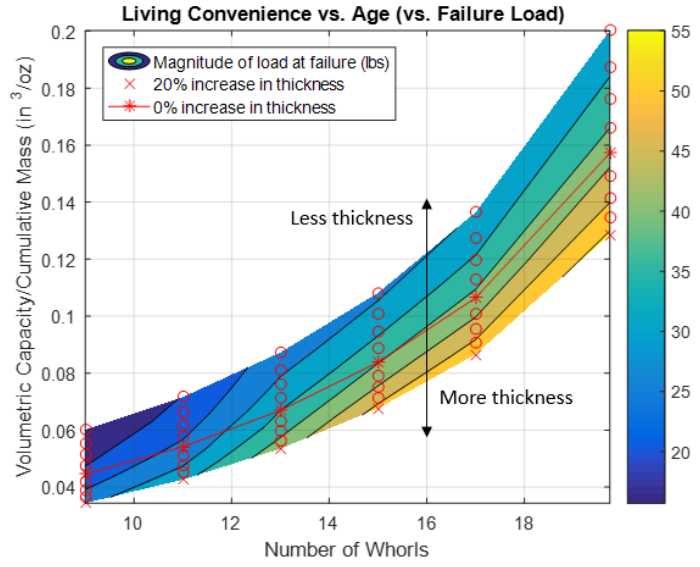
Figure 11. Living convenience increases with age. Contour levels represent the failure load